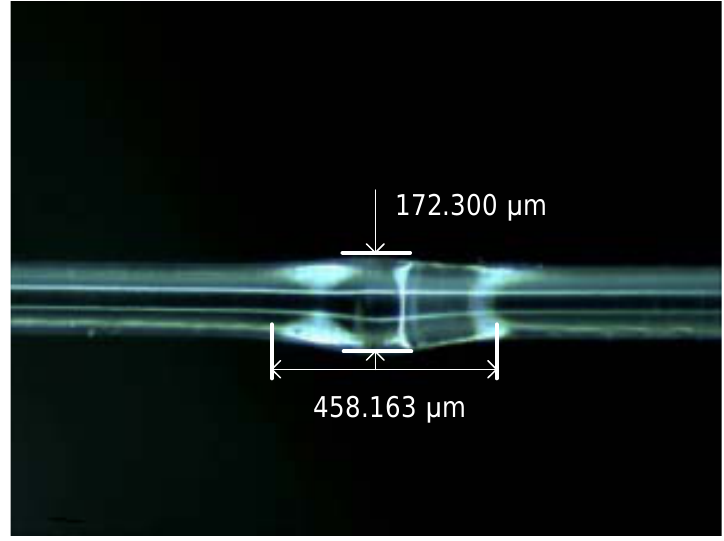
Figure 2. Side view of a waist-enlarged fusion bitaper.